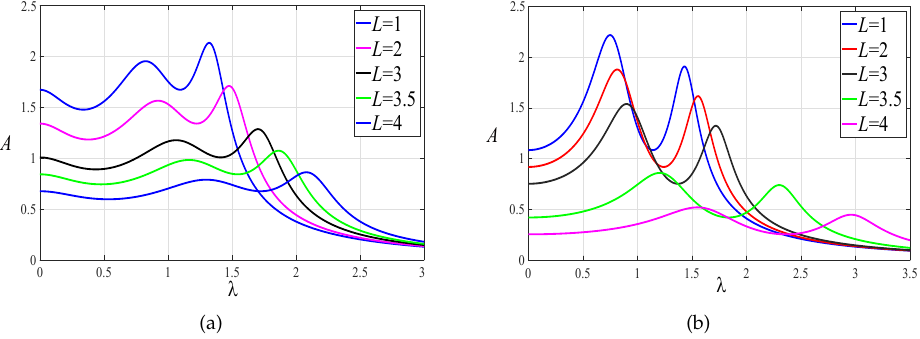
Figure 8. The effect of the magnification ratio L on the response of the primary system: ( a ) α 1 > 0. ( b ) α 1 < 0.